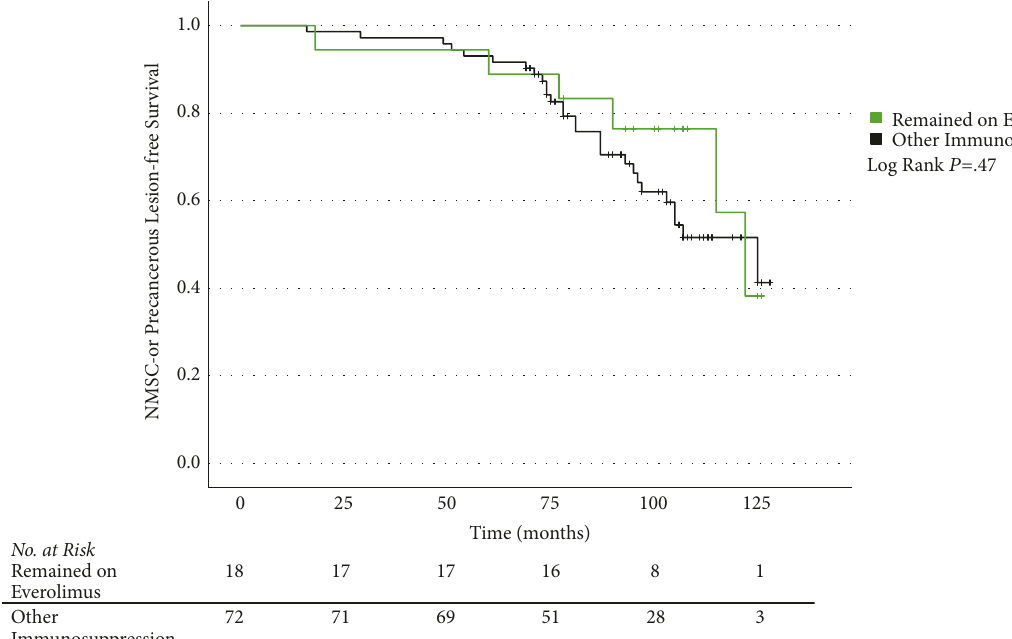
Figure 2: Skin cancer-free survival after lung transplantation. Kaplan-Meier plot showing the NMSC- or precancerous lesion-free survival after first lung transplantation comparing patients from the former everolimus arm, who remained on everolimus until dermatologic exam (“quasi per protocol”), to all other patients. Overall, 90 patients are included and analyzed with log-rank test for difference in median skin cancer-free survival ( P= .47). NMSC, nonmelanoma skin